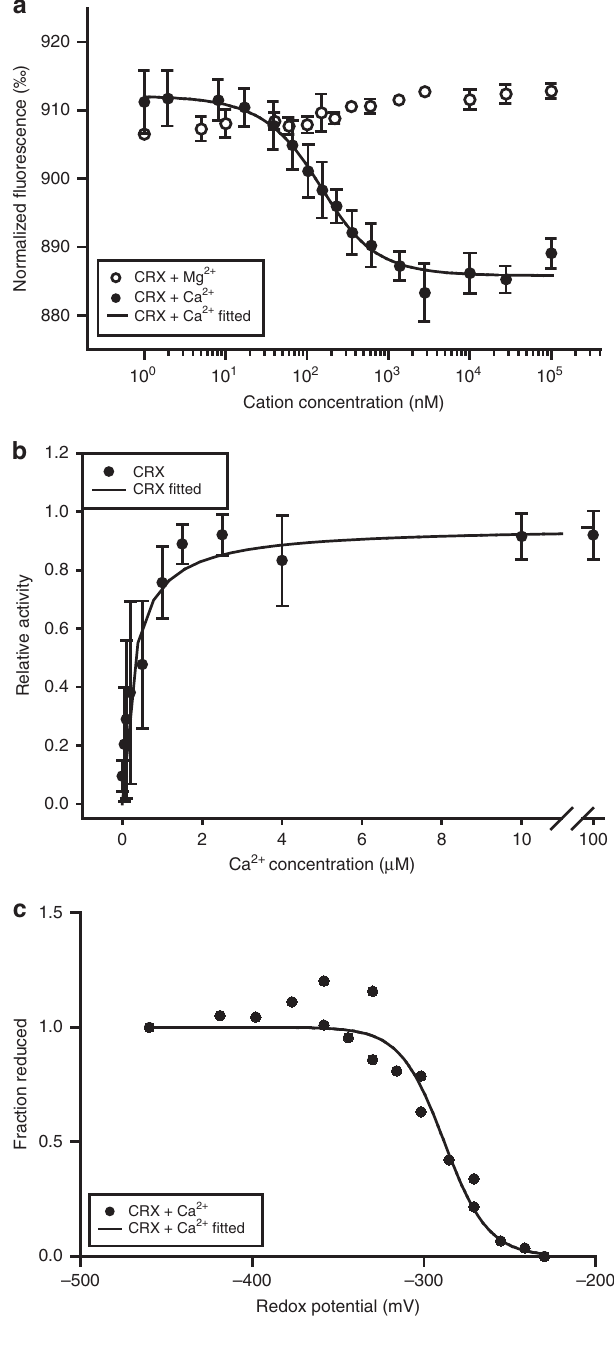
Figure 1 | In vitro characterization of calredoxin. ( a ) K d estimation for Ca 2 þ -binding by MST measurements. Fluorescently labelled recombinant WT CRX (CRX) was incubated with defined concentrations of free Ca 2 þ (filled circles) or Mg 2 þ (open circles) and the ratio of detected fluorescence before and after the thermophoretic movement was plotted against the corresponding cation concentration. Data for CRX incubated with Ca 2 þ were fitted according to the law of mass action (black line) and gave a K d of 88.2nM ± 16.5nM. Each data point represents the mean value of at least three experiments ( ± s.d.). ( b ) CRX shows Ca 2 þ -dependent redox activity. 10 m M recombinant WT CRX (closed circles) was reduced by E. coli NTR and NADPH in defined Ca 2 þ concentrations for 10min at